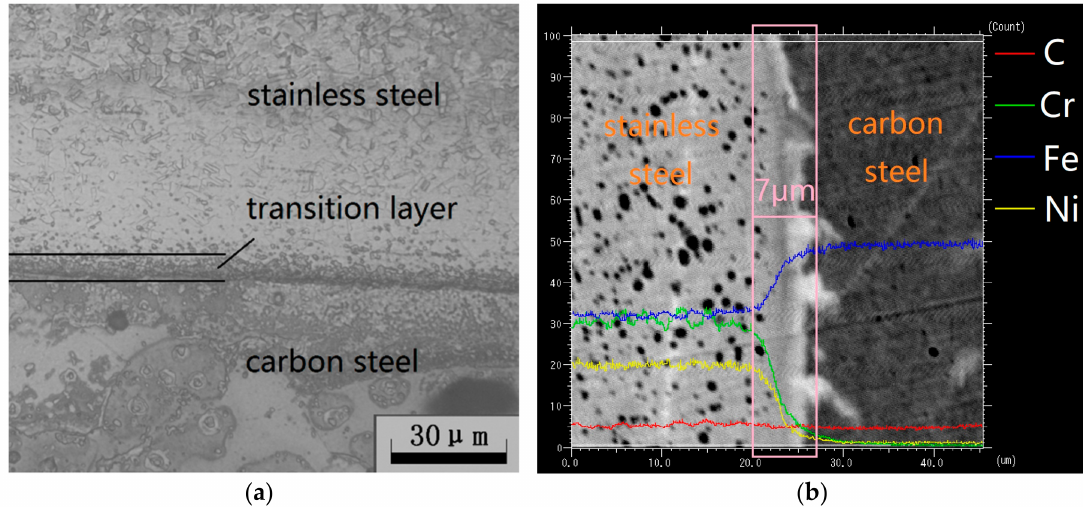
Figure 2. Metallographic microscope observation of the SCLP: ( a ) Metallographic micrograph; ( b ) electron probe